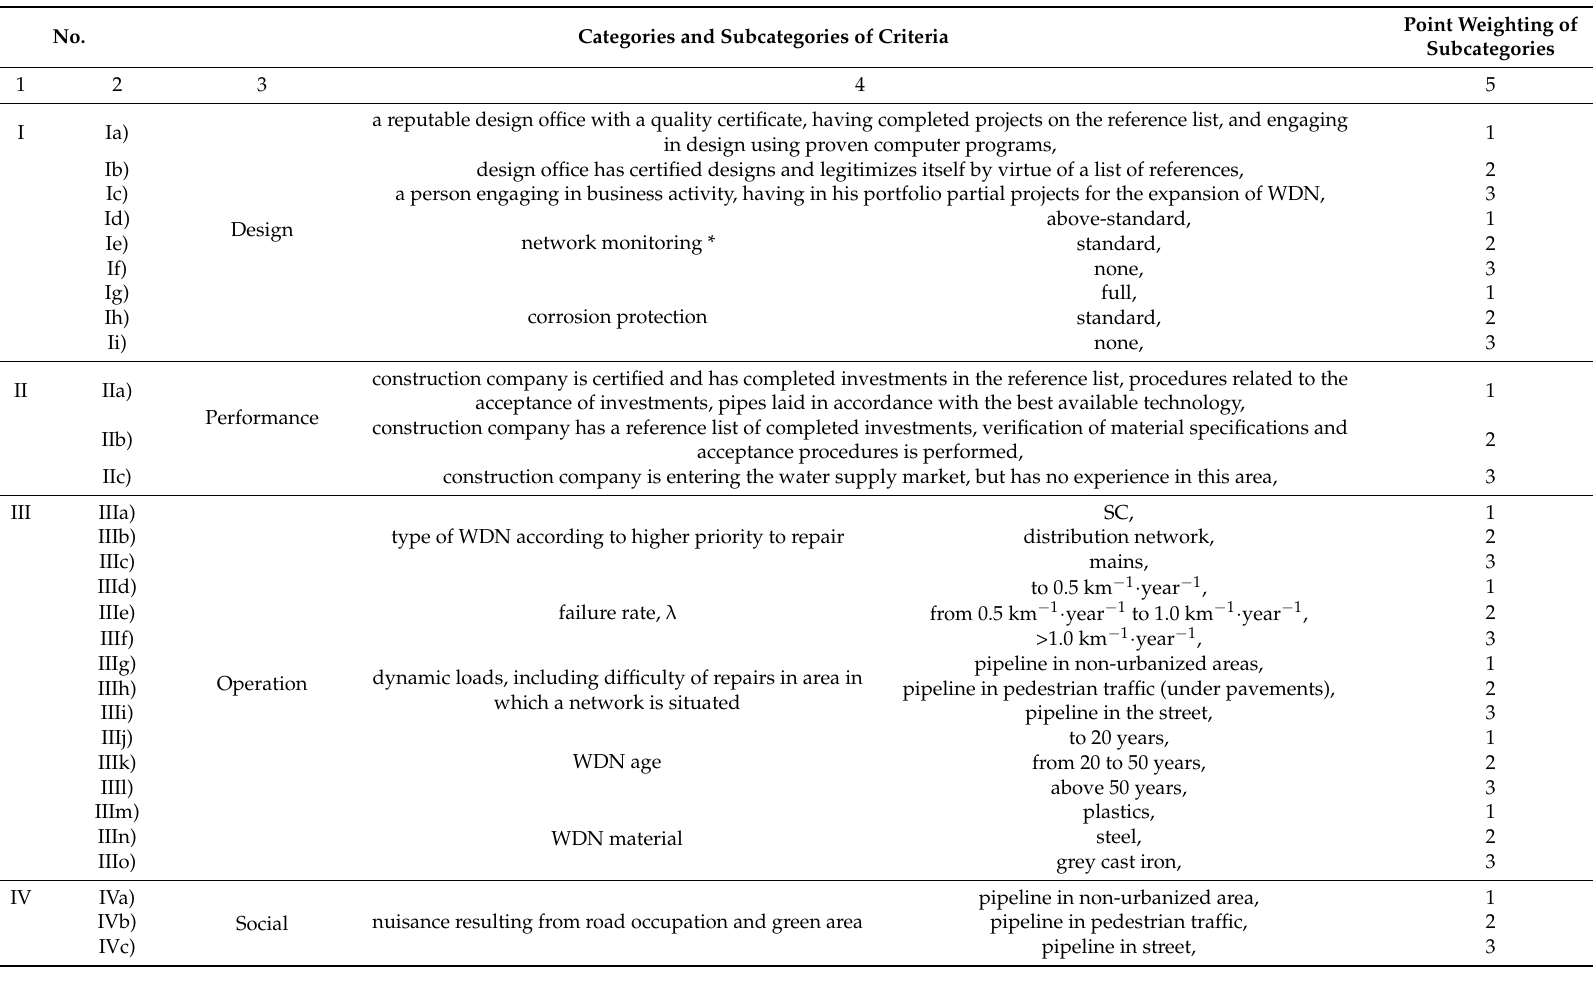
Table 3. Evaluation criteria